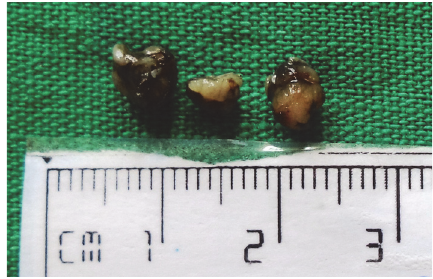
Figure 1: Gross appearance of the tissue.